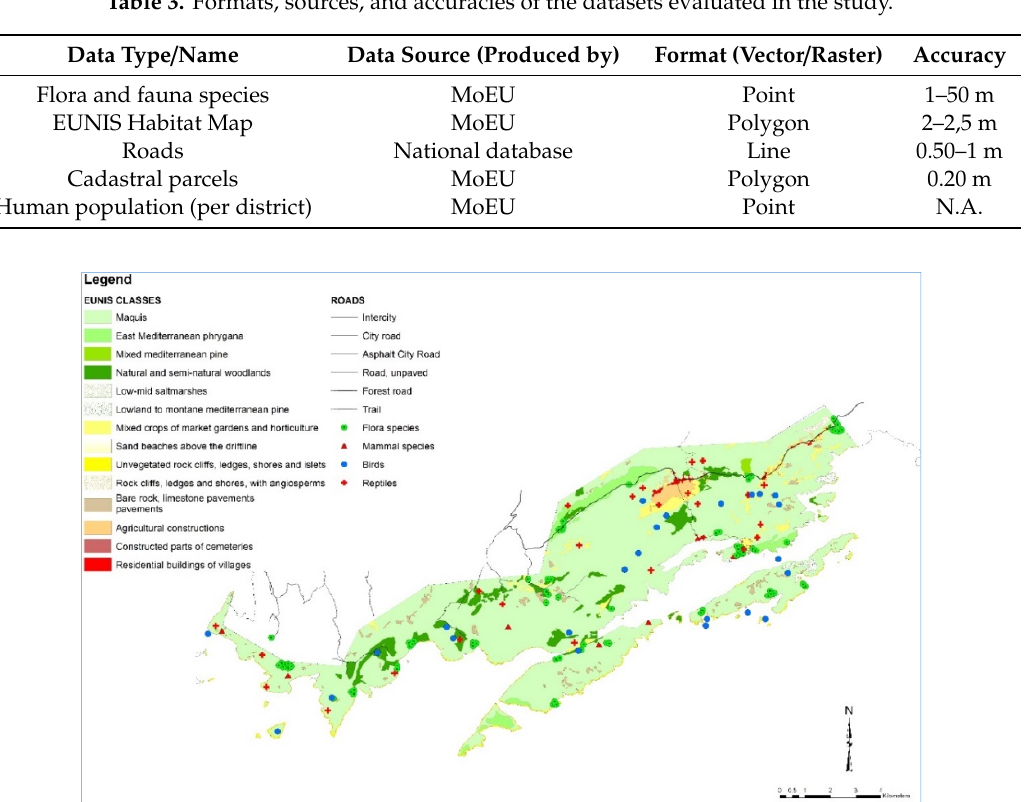
Figure 5. Endemic and / or threatened flora and fauna locations and the EUNIS Habitat classes determined identified and measured throughout the Kas-Kekova PA Biological Diversity Project carried out by MoEU [36].